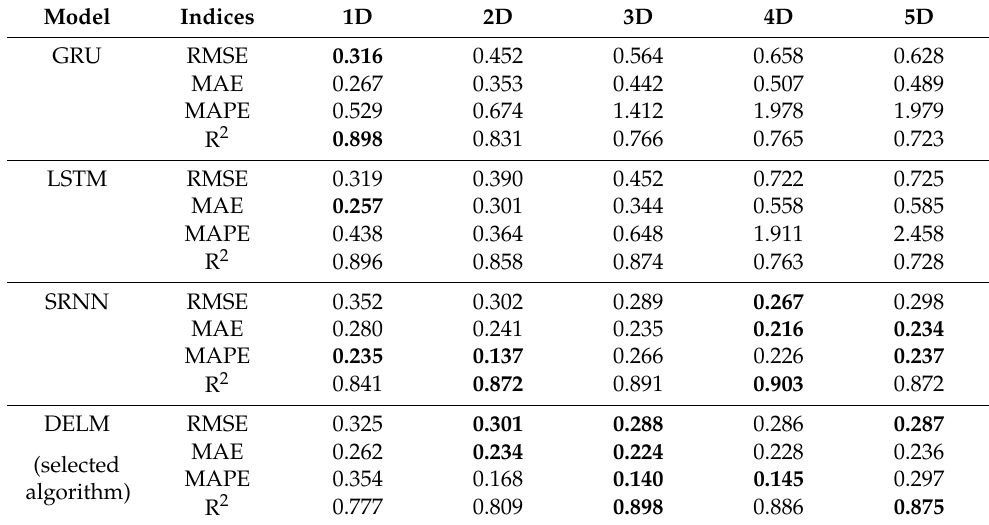
Table 2. Performance of different models with diverse input dimensions from 1 to 5 *.